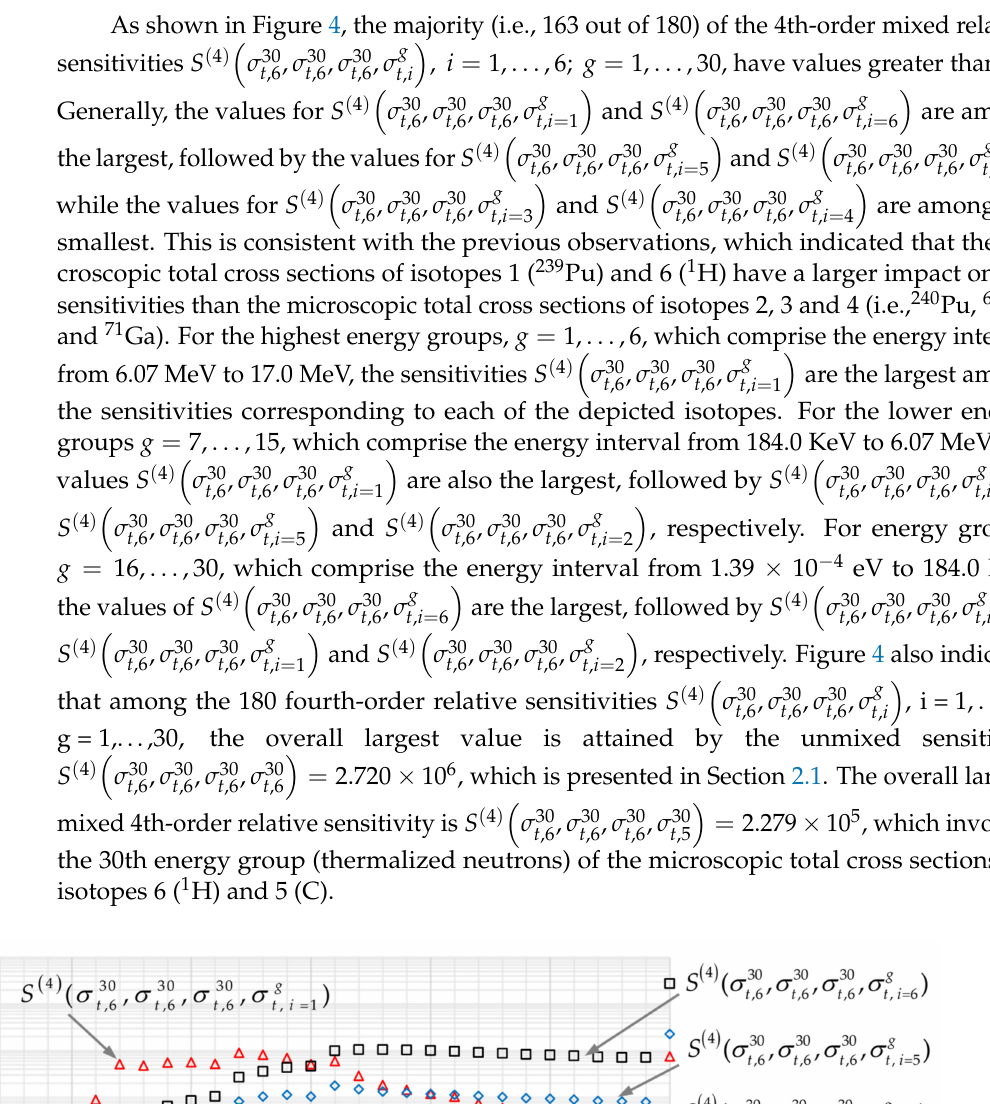
Figure 4. Numerical results for the 4th-order mixed relative sensitivities S ( 4 )